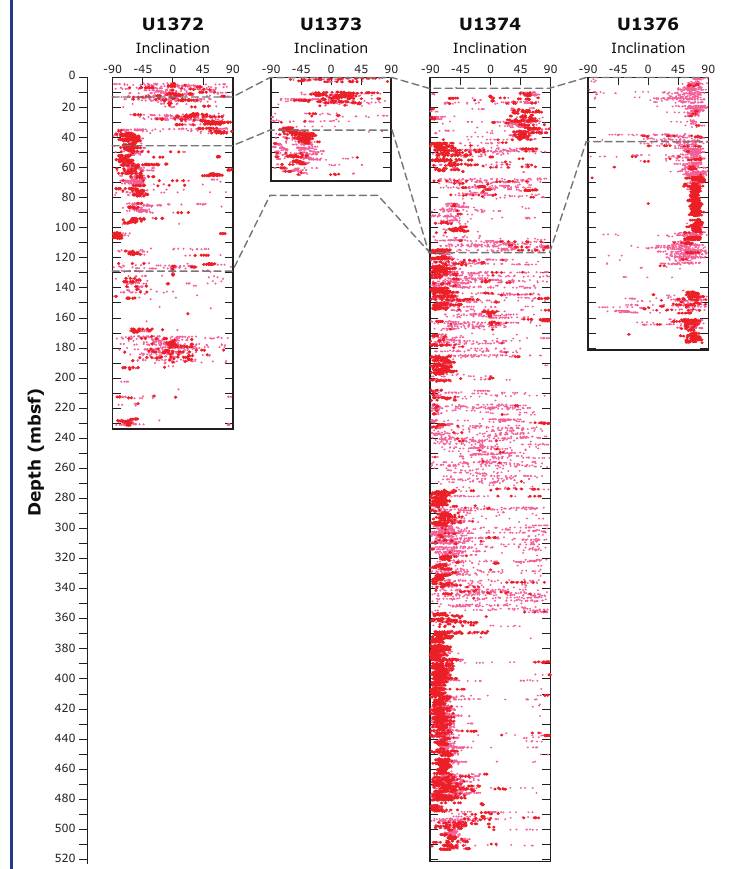
Figure 7. Compilation of downhole 2-cm archive inclination data. The drilled sequences of Sites U1372 (Canopus Guyot), U1373 and U1374 (Rigil Guyot), and U1376 (Burton Guyot) are displayed showing inclination data as measured at 2-cm intervals on the archive-half cores. Red colors (and larger symbols) are for the inclination data with principal component analysis (PCA) directions (40% of total number of data) that have smaller misfits and thus are of higher quality. Pink colors (and smaller symbols) are for PCA directions (60%) that resulted in larger misfits and thus are of lower quality. Downhole data plots for Sites U1375 and U1377 are omitted because of the shallow penetration depths. Figure after Koppers et al.